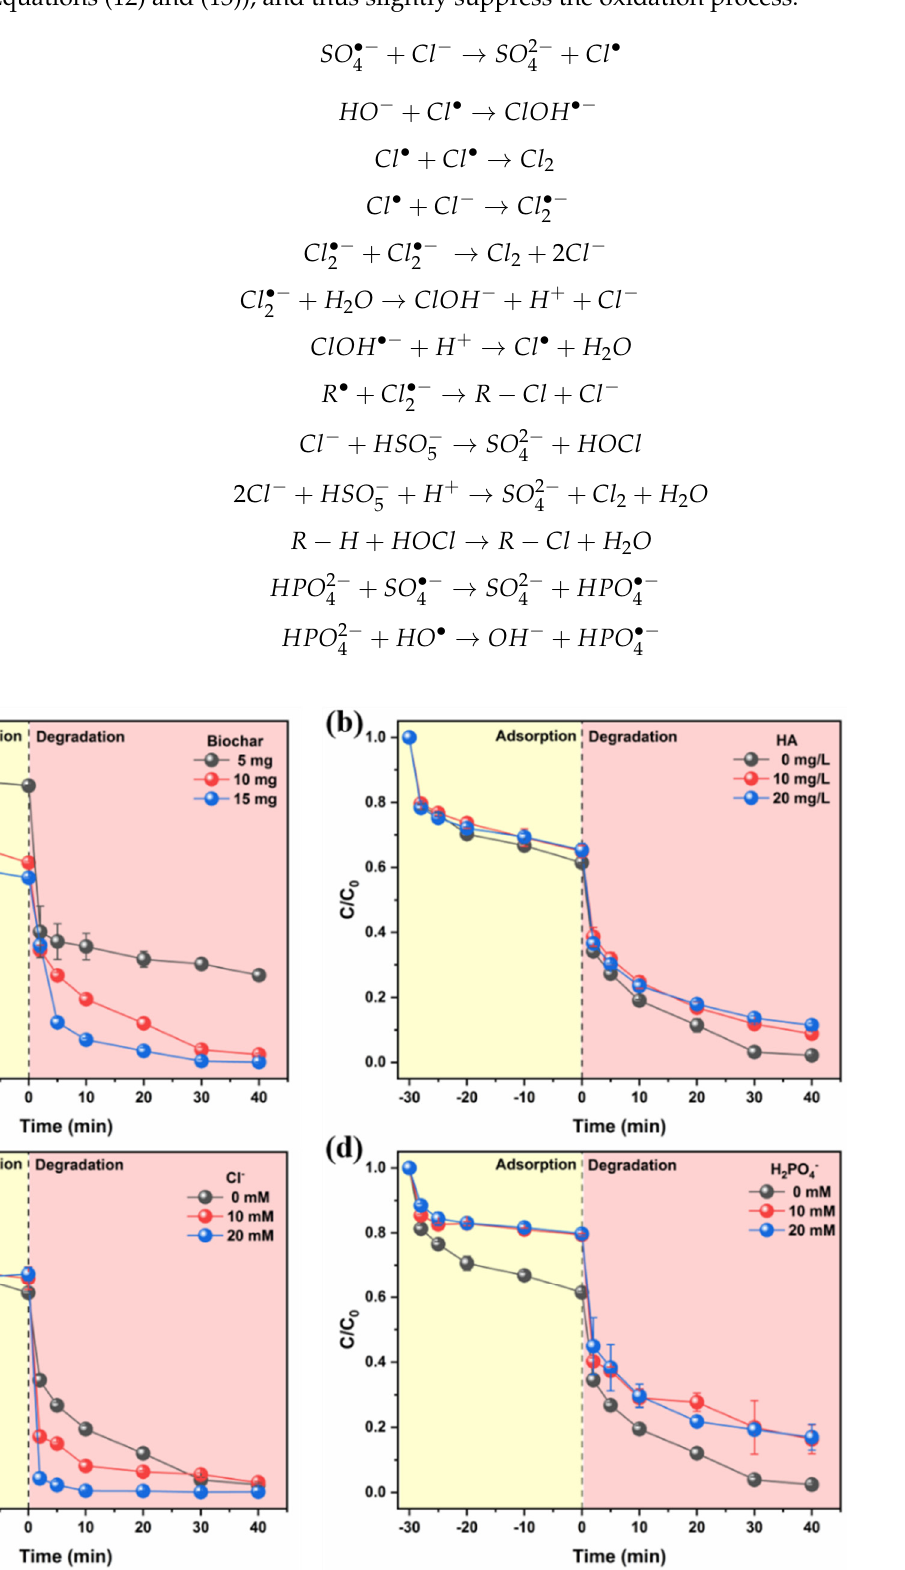
− ( c ), H − ( d ) on SDZ 2 PO 4